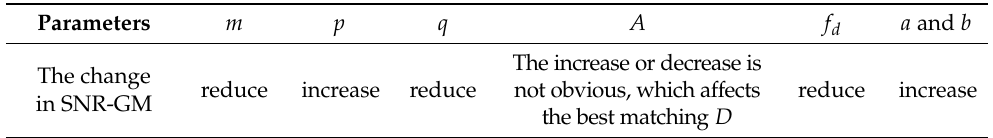
Table 2. The influence of parameters on